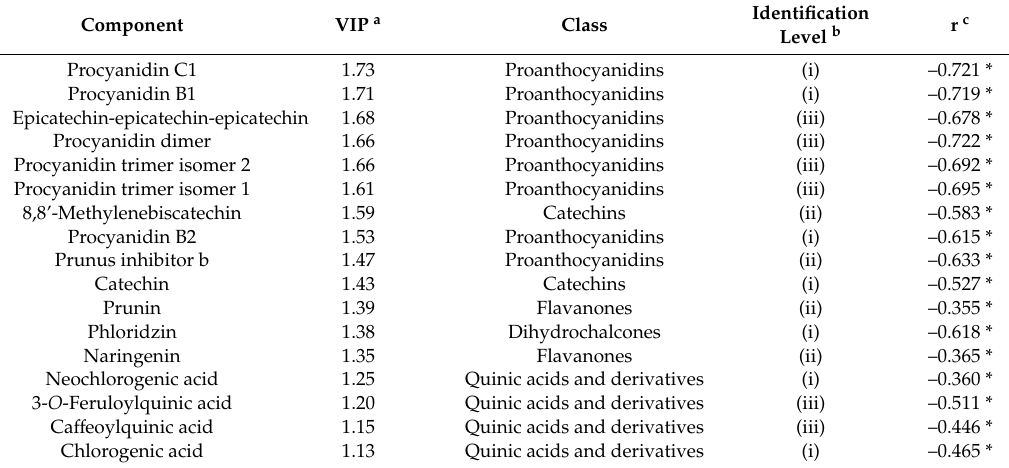
Figure 1. Relation of 50% inhibiting concentration (IC 50 ) of peach pulp against alpha-glucosidase activity by a PLS model based on the pulp extract of 33 peach cultivars. ( A ) Summary of Fit Plot PLS; ( B ) observed vs predicted; ( C ) permutation plot for PLS [R2 = (0.0, 0.22); Q2 = (0.0, –0.531)]. Table 2. Phytochemical constituents in peach pulp contributing to alpha-glucosidase inhibitory activity and Pearson’s correlation coefficients (r) between these constituents’ profiling and the IC 50 of alpha-glucosidase inhibiting activity.